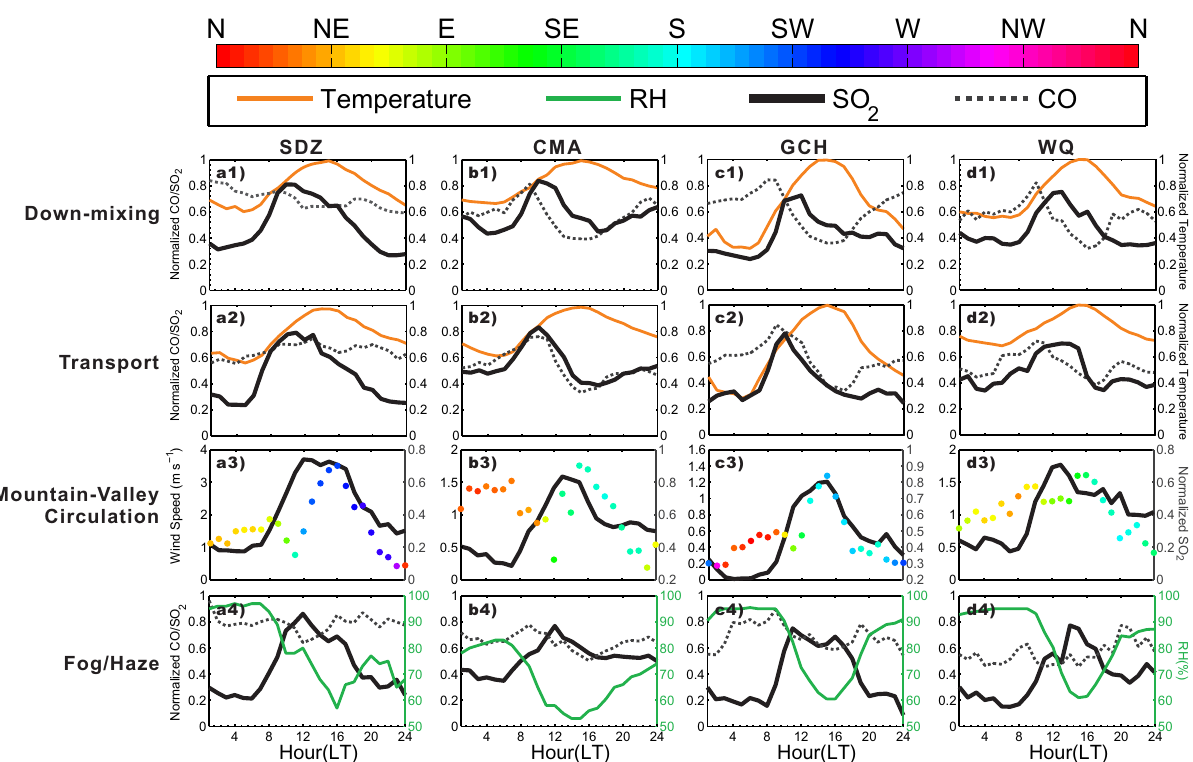
Figure 5. Averaged diurnal variation patterns for (1) the PBL down-mixing, (2) the plume transport, (3) the mountain valley breeze, and (4) the fog/haze case for (a) Shangdianzi, (b) China Meteorological Administration, (c) Gucheng and (d) Wuqing.